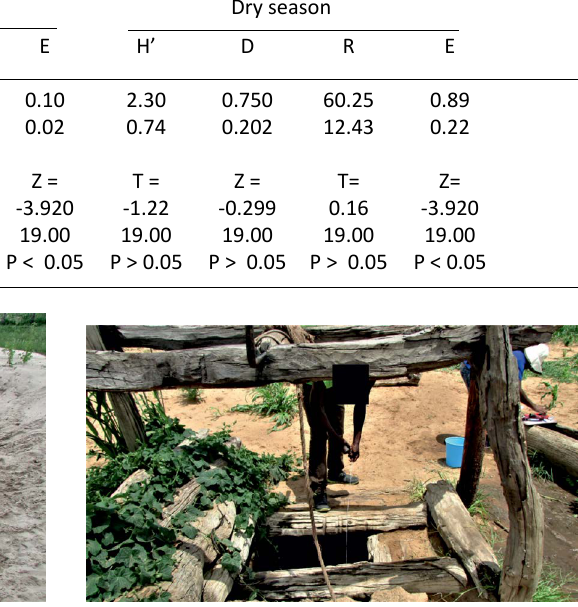
Fig. 3. A picture of type 3 deep hand-dug wells found in Ohangwena and Omusati regions of the CEB in which animals cannot walk into the